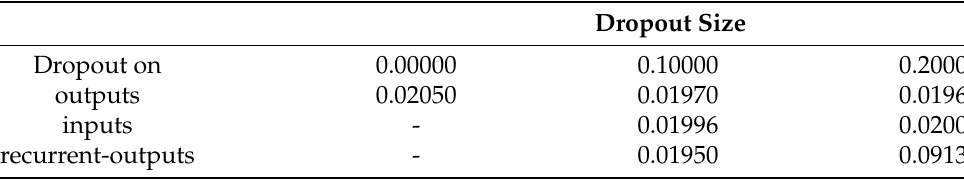
Table 2. Validation MSE for different dropout size (Loc.